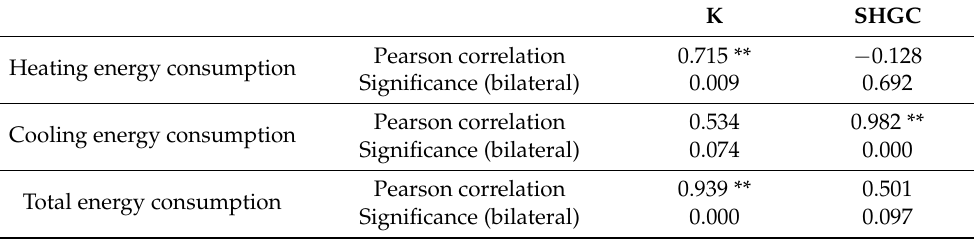
Figure 12. Relationships between window thermal performance and total energy consumption and solar radiation heating. Table 9. Correlations between window thermal performance and energy consumption.